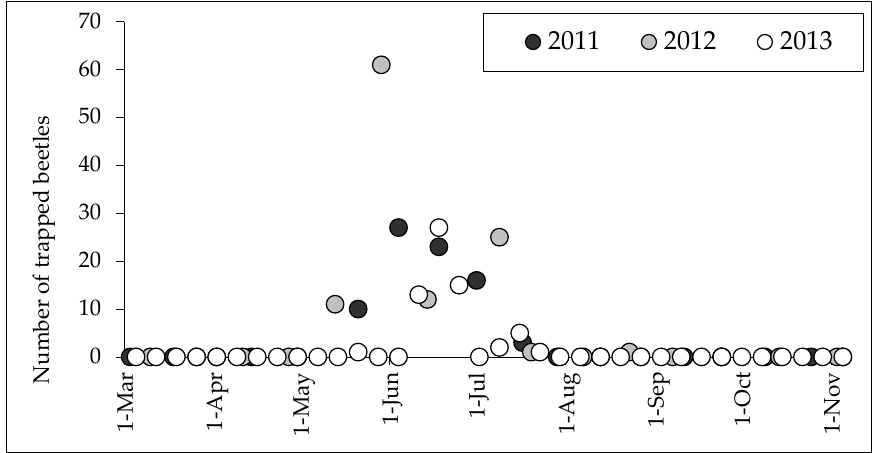
Figure 5. Linear regression with 95% confidence interval (dashed lines) of the female individuals and their relationship to number of eggs and body size ( A ), body size–length of eggs ( B ), width ( C ), length and width ( D ), content ( E ), and volume of eggs ( F ).